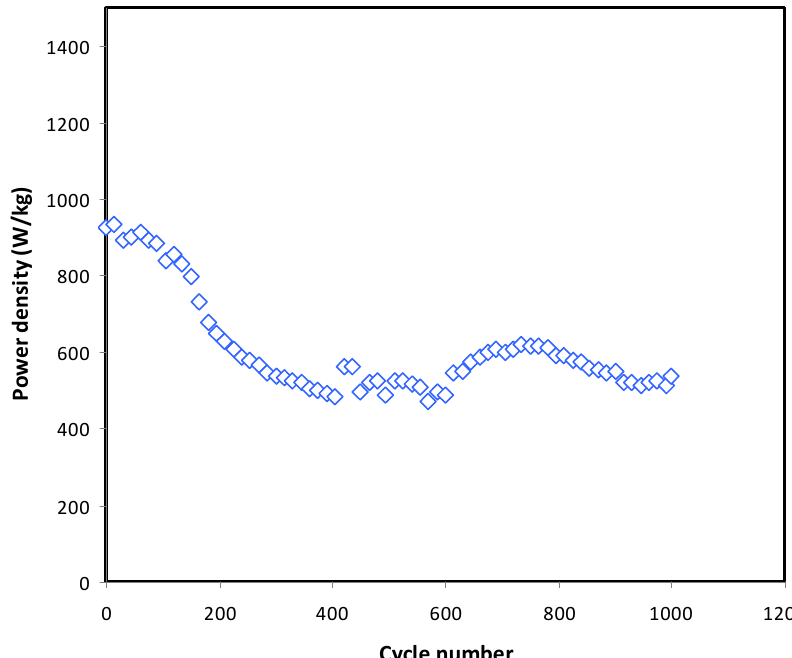
Figure 13. Power density of the fabricated EDLC throughout 1000 cycles.